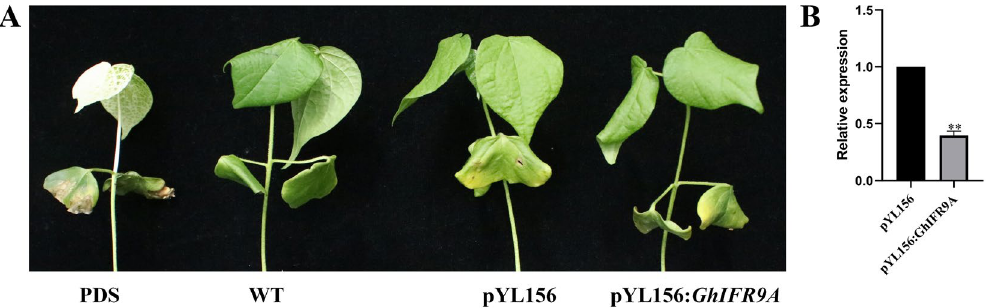
Figure 8. Silencing GhIFE9A via VIGS increased sensitivity to salt stress. ( A ) Phenotype of cotton leaves after VIGS, ( B ) qRT-PCR for GhIFE9A gene under salt stress. WT: No infection, salt stress: 200 mM